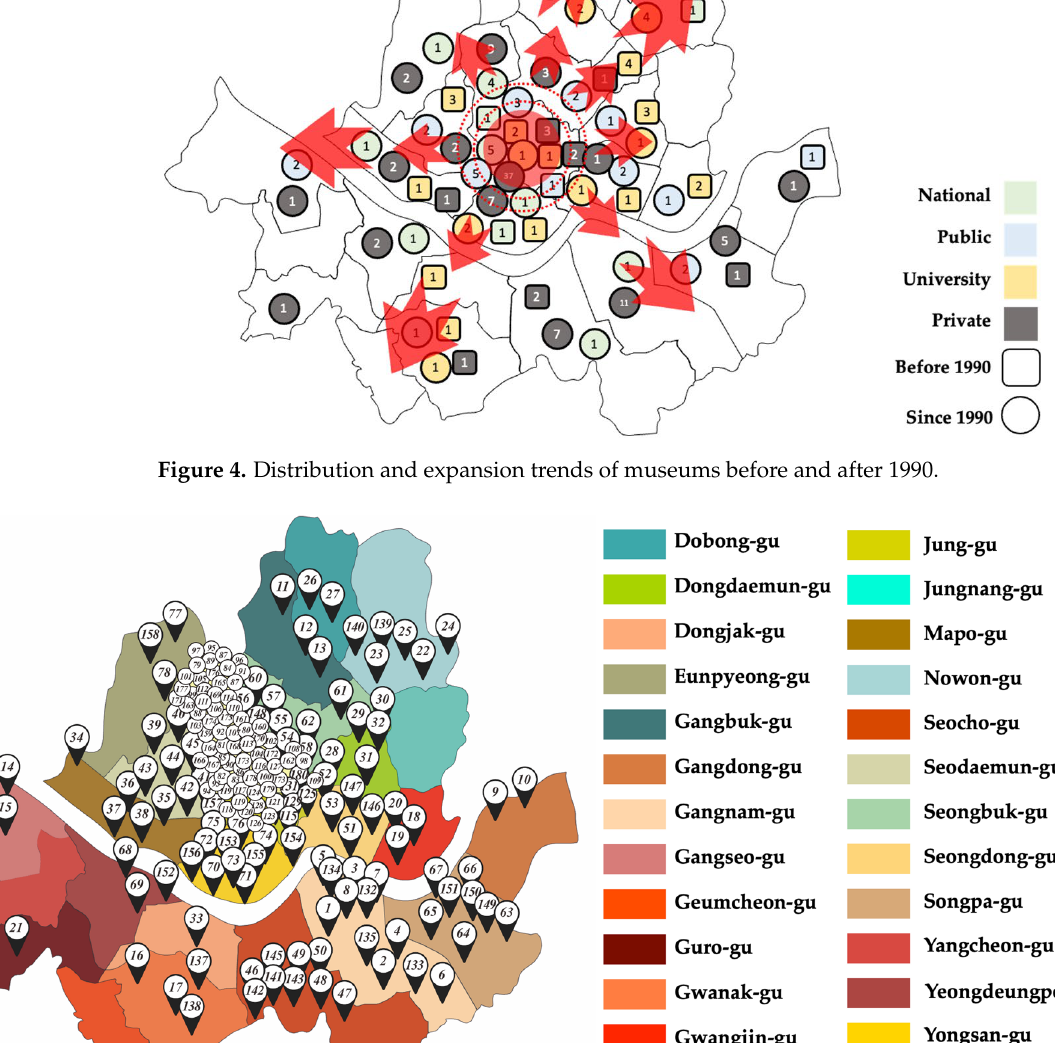
Table 4. Urban hierarchy actuality in Seoul.